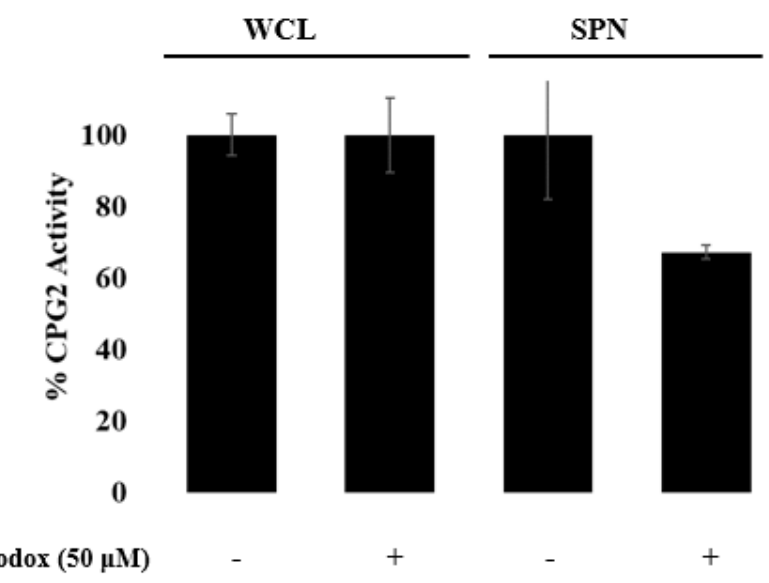
Figure 10. The enzymatic activity of whole cell lysate (WCL) and supernatant (SPN) samples were analyzed in the presence and absence of aurodox. Aurodox does not inhibit the expression of CPG2 in WCL, but it inhibits the secretion of CPG2 into the supernatant by the T3SS.